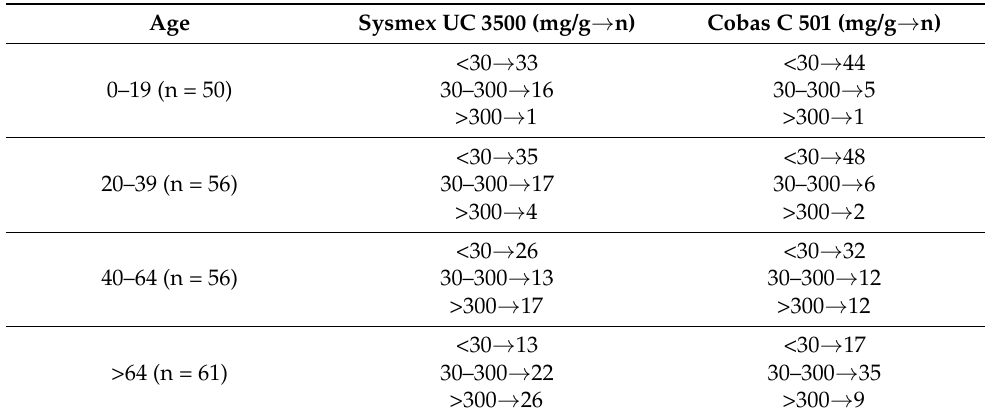
Table 4. Comparison of 223 samples of albumin/creatinine ratio calculated using the semi- quantitative and quantitative methods, redistributed by